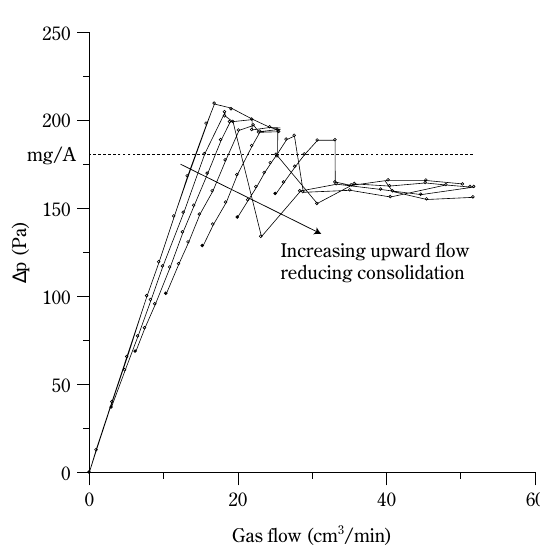
Gas pressure drop versus gas flow for a given mass of xerographic toner (with 0.2%wt of silica) in states of reduced consolidation obtained by allowing the powder to settle under an upward-directed gas flow. Curves in the right-hand direction correspond to increasing values of the decompressing gas flow and hence to decreasing values of the consolidation stress s c